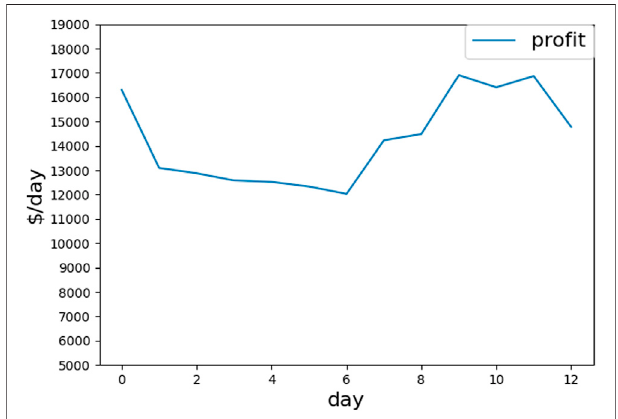
FIGURE 10 | Operational bene fi ts of the integrated energy